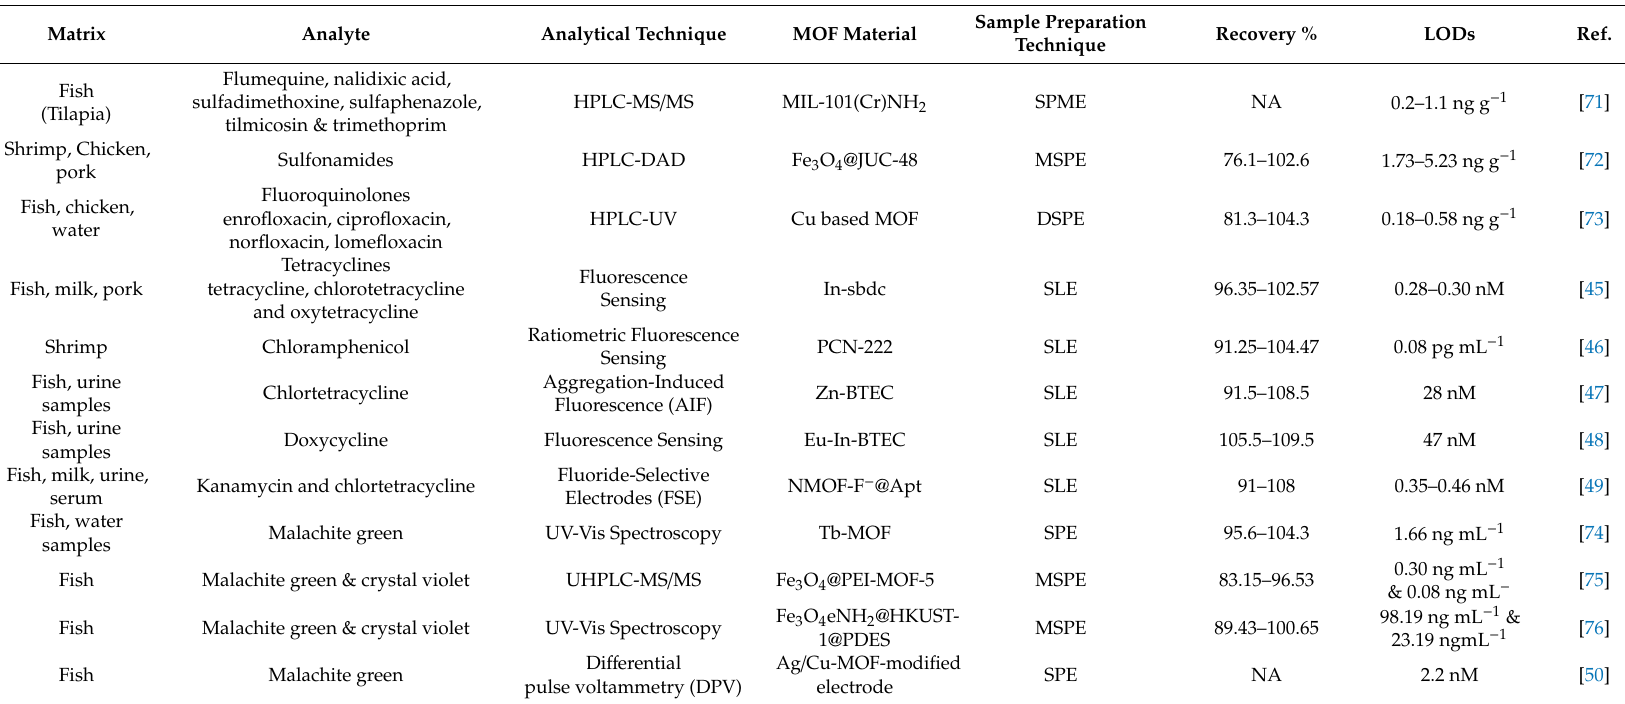
Table 1. Applications of MOF materials for the extraction and detection of antibiotics and antimicrobial agents in seafood and fish